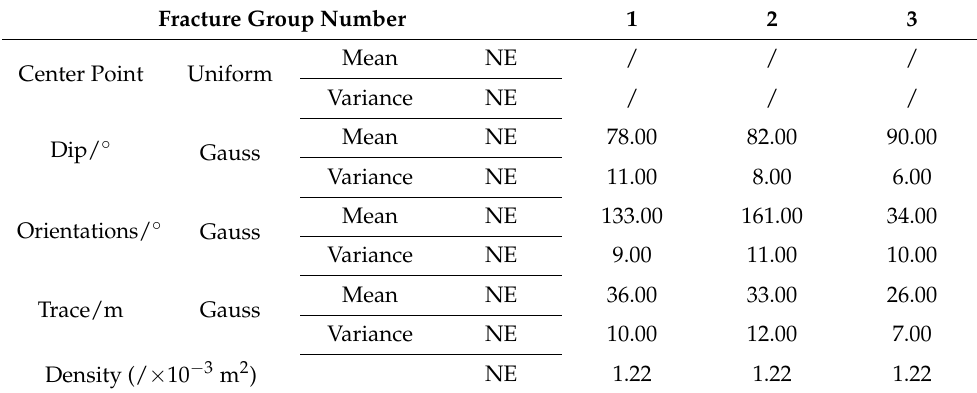
Table 3. In-situ fracture survey data for different fracture